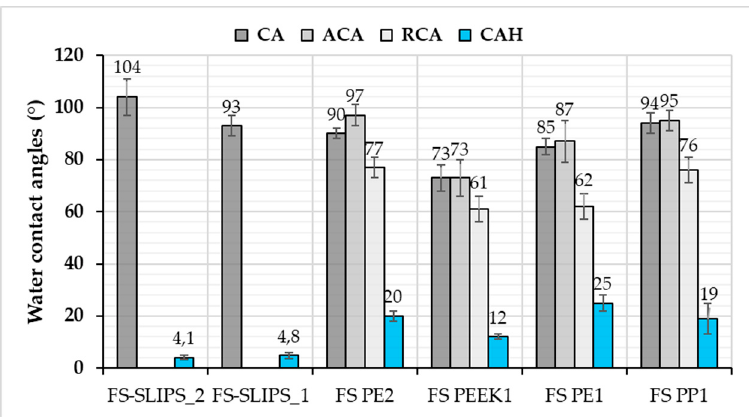
Figure 6. Water contact angles for flame-sprayed (FS) polymer coatings and FS-SLIPS. CA: static contact angle; ACA: advancing contact angle; RCA: receding contact angle; and CAH: contact angle hysteresis. Coatings are as-sprayed (1) or polished (2) prior testing.